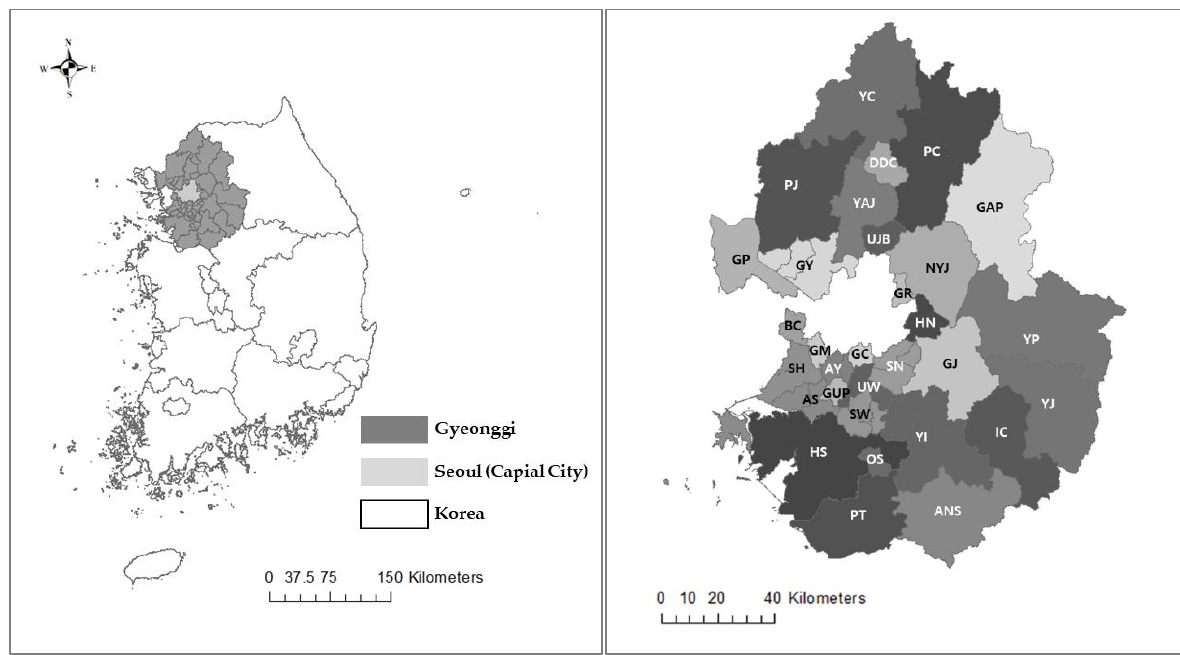
Figure 1. Study area: Gyeonggi Province in Korea. The 31 districts in Gyeonggi Province are Ansan(AS), Anseong(ANS), Anyang(AY), Bucheon(BC), Dongducheon(DDC), Gapyeong(GAP), Gimpo(GP), Goyang(GY), Gunpo(GUP), Guri(GR), Gwacheon(GC), Gwangju(GJ), Gwangmyeong(GM), Hanam(HN), Hwaseong(HS), Icheon(IC), Namyangju(NYJ), Osan(OS), Paju(PJ), Pocheon(PC), Pyeongtaek(PT), Seongnam(SN), Siheong(SH), Suwon(SW), Uijeongbu(UJB), Uiwang(UW), Yangju(YAJ), Yangpyeong(YP), Yeoju(YJ), Yongin(YI), and Yeoncheon(YC).